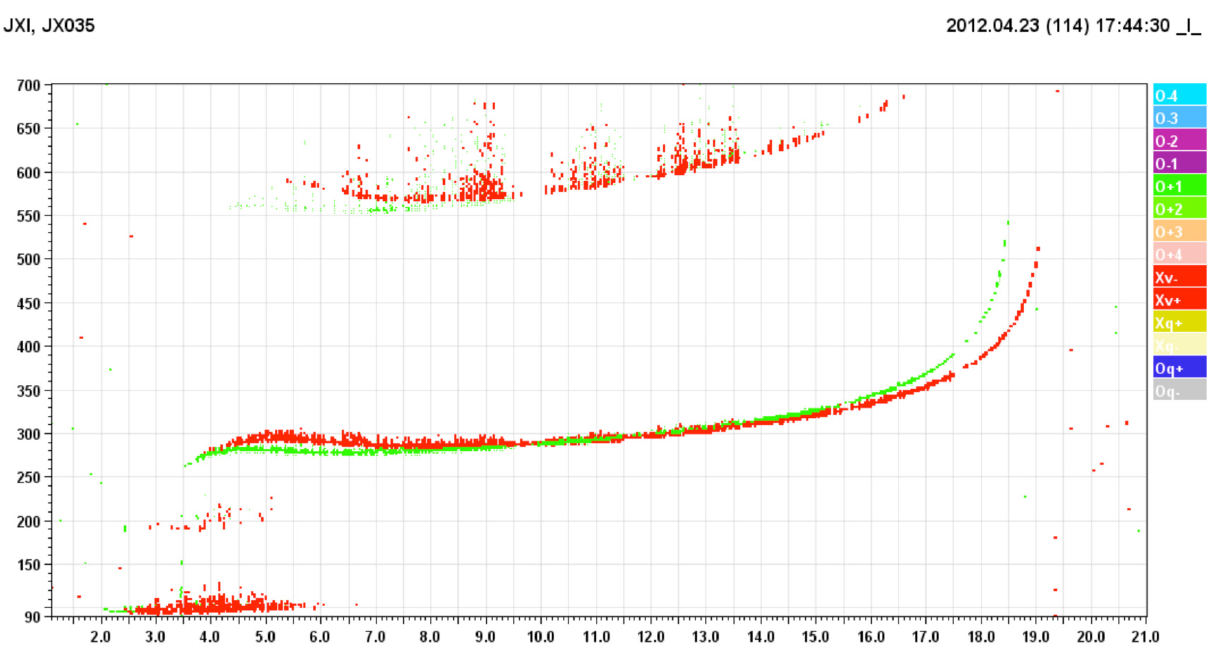
Figure 6. Ionogram of CAS-DIS on April 23, 2012, in station of Ji’an (LT).